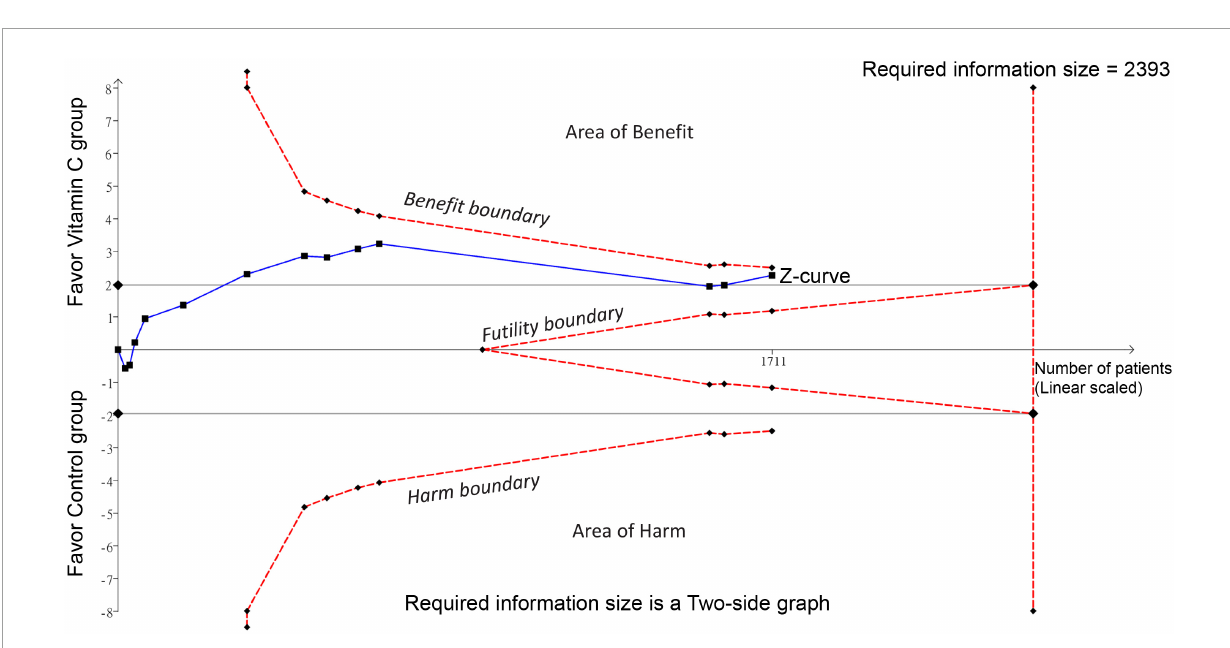
FIGURE4 Trial sequential analysis (TSA) showing no crossing between the cumulative Z curve and the trial sequential monitoring boundary or the required information size, indicating insufficient and inconclusive evidence supporting the association of intravenous vitamin C supplementation with a decreased risk of